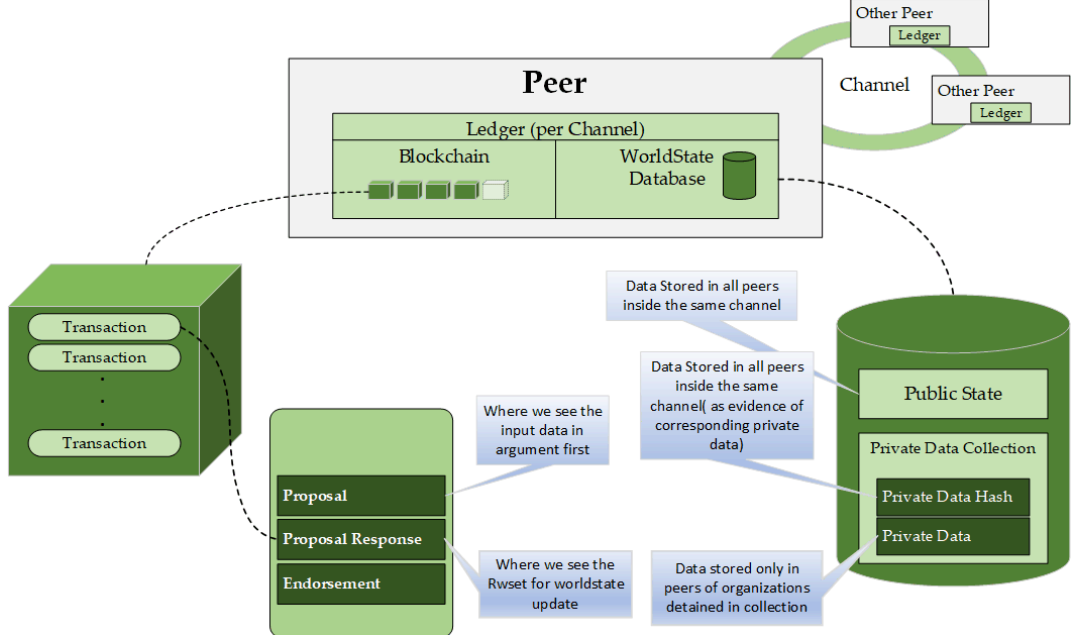
Figure 6. Ledger implementation